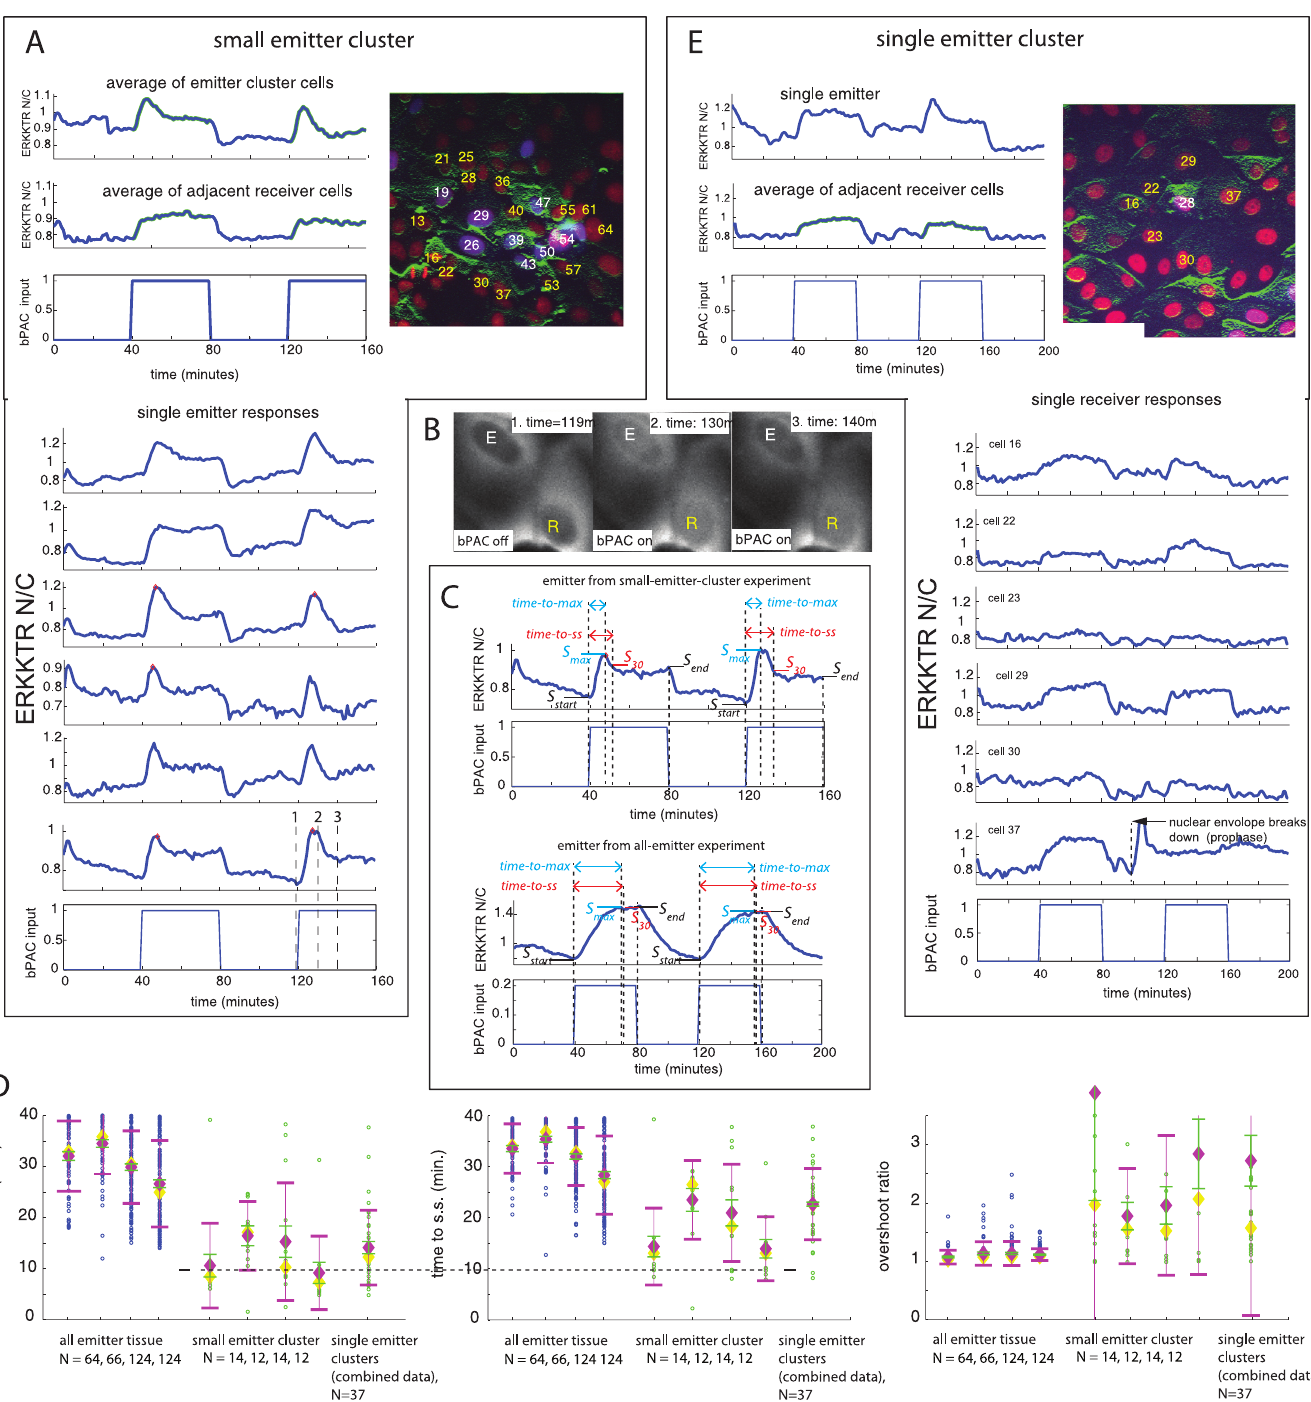
Fig 3. Single cell emitter ERK-KTR N/C signals from small-emitter-cluster monolayers can be qualitatively different from emitters in all-emitter monolayers. Images of monolayers in (A) and (E): merged image of green (filtered ERK-KTR with horizontal line detector filter), red (nuclear maker), blue (nuclear bPAC marker) where emitter nuclei are purple (red+blue), and receiver nuclei are red. Labeled nuclei: white label (emitter), yellow label (receiver). (A) Results for a small-emitter-cluster monolayer. Left top panel: top plot: small-emitter-cluster average of ERK-KTR N/C signal, middle plot: adjacent receivers average of ERK-KTR N/C signal, bottom: bPAC input. Right image: small emitter cluster. Bottom panel: single cell emitter measurements of ERK-KTR N/C signal from the small-emitter-cluster experiment. (B) Time dependent snapshots of ERK-KTR reporter from experiment presented in (A) for the emitter (white ‘E’ label) whose response is plotted in the bottom single cell emitter plot in (A) (dashed vertical lines depict snapshot times) and an adjacent receiver (yellow ‘R’ label). (C) Illustrations depicting measurements used for time-to- max, time-to-ss, and overshoot-ratio statistical metrics. The time-to-max is the time to reach S , max signal during pulse. The time-to-ss is the time to reach S 30 , i.e. max when the signal is first within 30 percent of S end (end-of-pulse signal value) relative to S max . Given S start (start-of-pulse signal value), the overshoot ratio is S max (cid:0) S start . Top S end (cid:0) S start